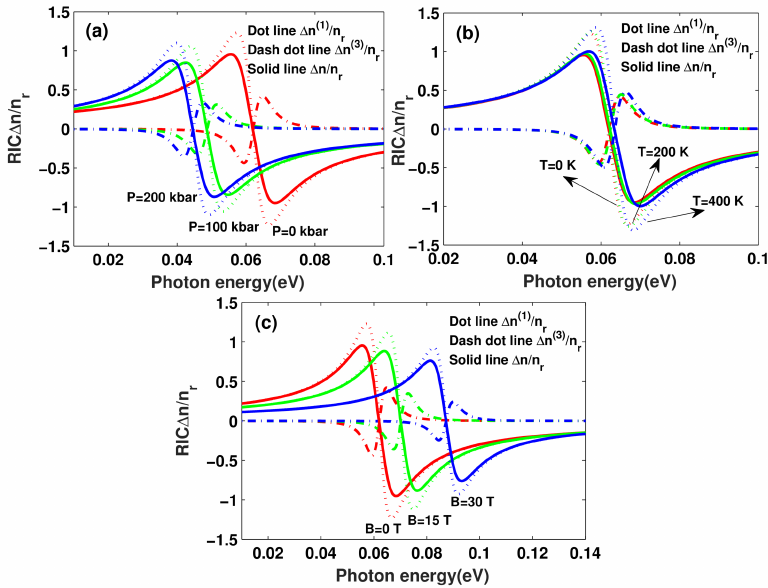
Figure 6. The refractive index changes (RICs) with photon energy for three different hydrostatic pressure P ( a ), temperature T ( b ), and applied magnetic field B ( c )